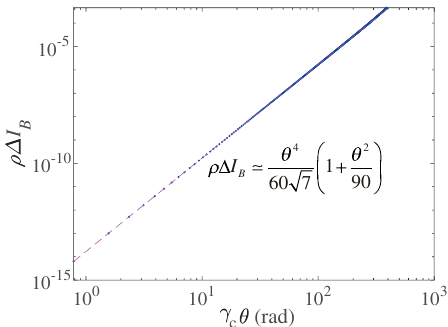
FIG. 5. The theoretic limit of longitudinal emittance contribu- tion of the third kind of dipole (C) at various bending angles. The blue dots are the exact integral results, and the magenta dashed line shows the approximation in the picture, which is valid in a wide range of bending